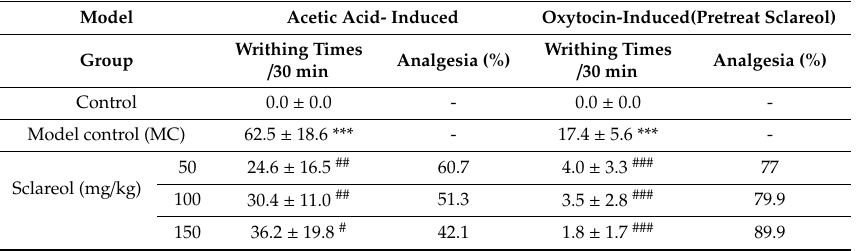
Table 1. E ff ect of sclareol on acetic acid- and oxytocin-induced writhing tests.